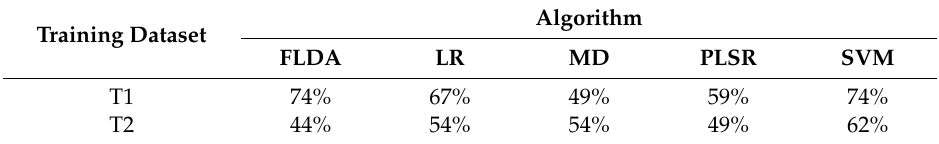
Table 4. The classification accuracy of five commonly used algorithms on two different training